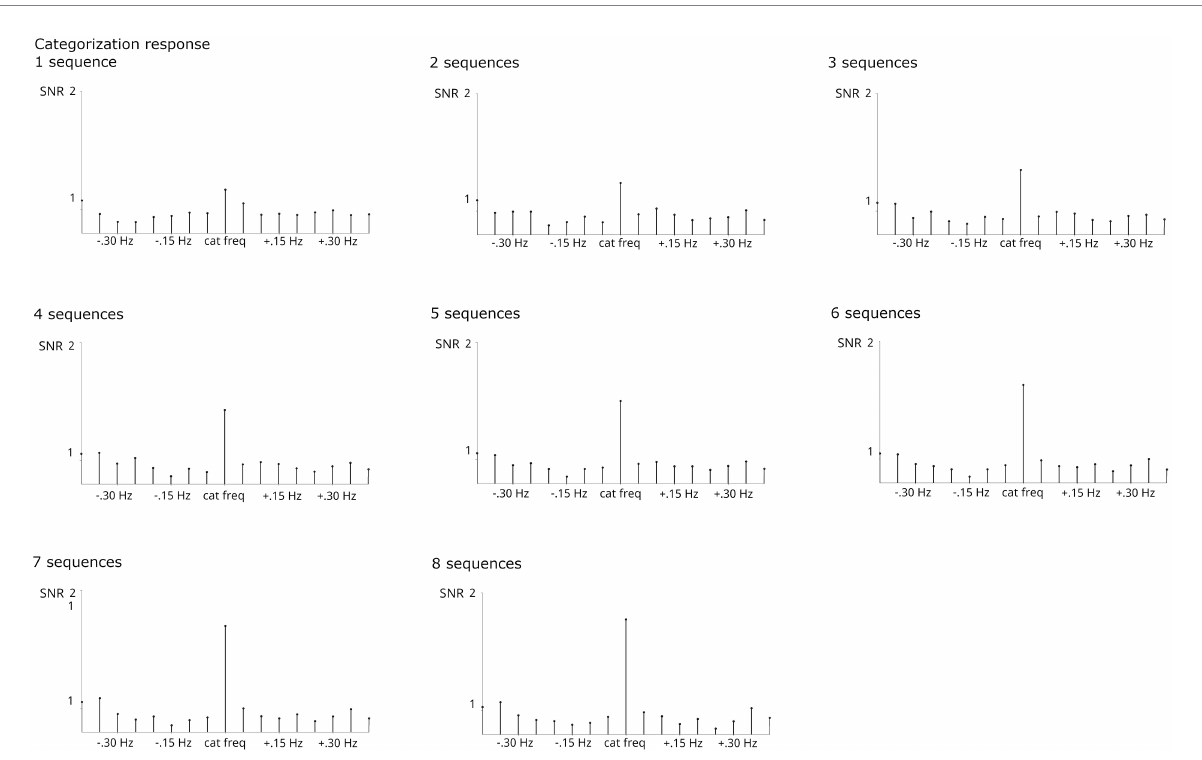
FIGURE 7 SNR of grand-average categorization responses summed across harmonics 1–19 and compared across numbers of sequences averaged for a subsample of N = 20 who provided usable data for at least 8 sequences. The respective N contributing to each analysis is specified per graph. Significant categorization responses were obtained in all analyses. Averaging across larger numbers of sequences increased response